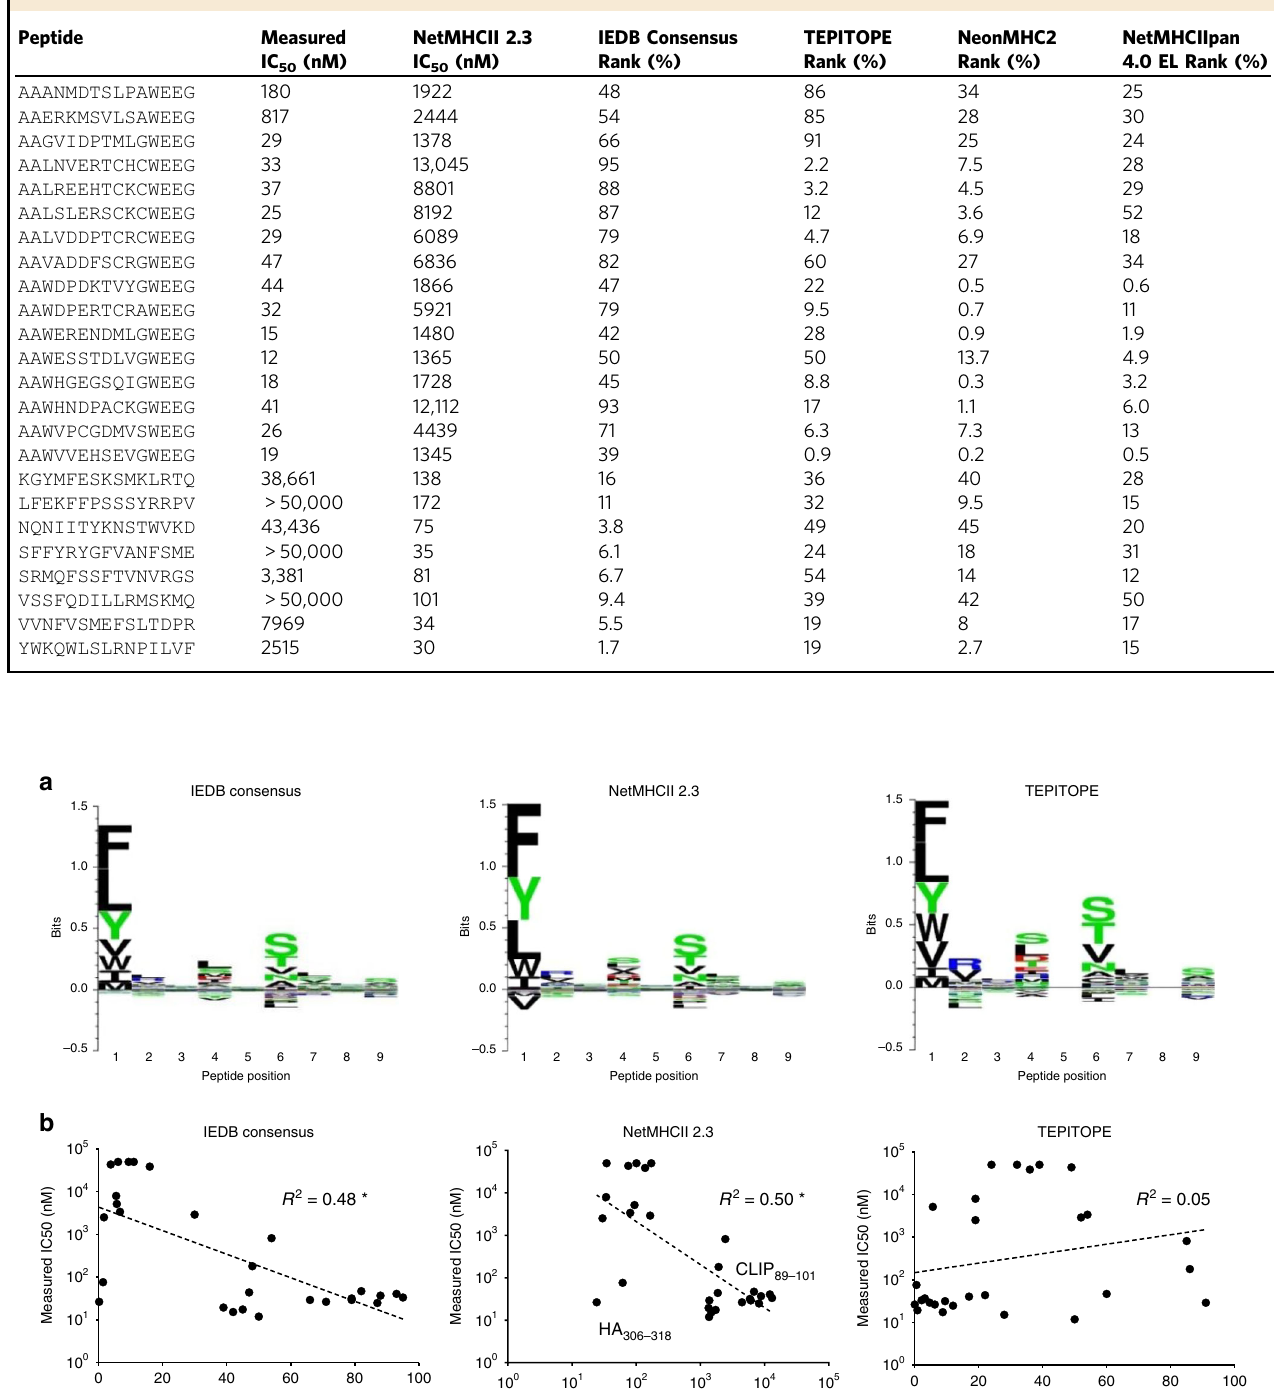
Table 1 Validation of library-enriched HLA-DR401-binding motif. Table of peptides either enriched by our randomized 9mer HLA-DR401 library selections, but not predicted to bind HLA-DR401 by NetMHCII 2.3 or IEDB Consensus, or derived from In fl uenza A virus and predicted to bind HLA-DR401 but not matching our enriched motif, with algorithmic prediction values and IC 50 values measured via fl uorescence polarization competition assays.